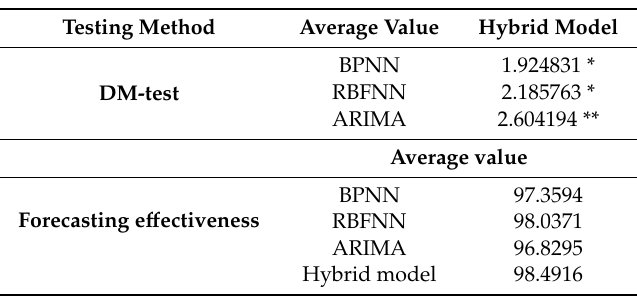
Table 7. Results of DM test and forecasting e ff